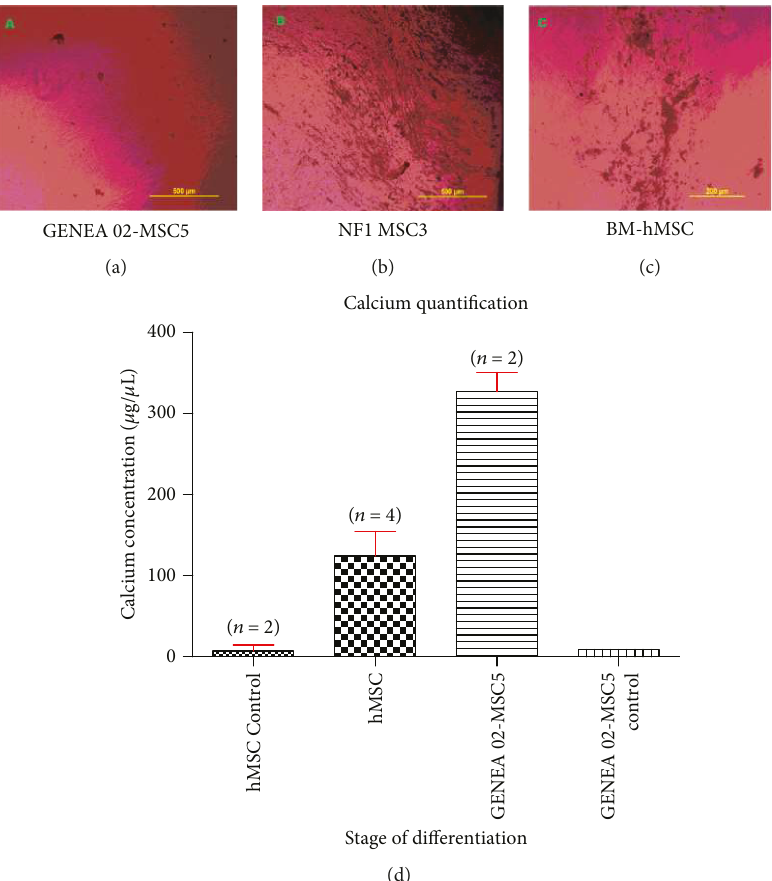
Figure 6: Morphological characteristics of GENEA 02-MSC5 (a), NF1-MSC3 (b), and BM-hMSCs (c) after 31 days of directed osteogenic di ff erentiation. Both NF1-MSC3 and BM-hMSCs displayed a strong osteogenic di ff erentiation ability as indicated by the presence of a mineralized matrix in the culture. GENEA 02-MSC5 cells, however, showed a limited osteogenic di ff erentiation ability when compared with NF1-MSC3 cells. (d) Average calcium concentration in BM-hMSCs and ESC-derived MSCs after 31 days of culture in osteogenic di ff erentiation media or MPC Growth MEM media. A higher concentration of calcium was observed in GENEA 02-MSC5 and BM- derived MSCs after 31 days of directed osteogenic di ff erentiation when compared with the concentration of calcium detected in GENEA 02-MSC5 and BM-hMSCs (negative controls) cultured in MPC Growth MEM media during the same period of